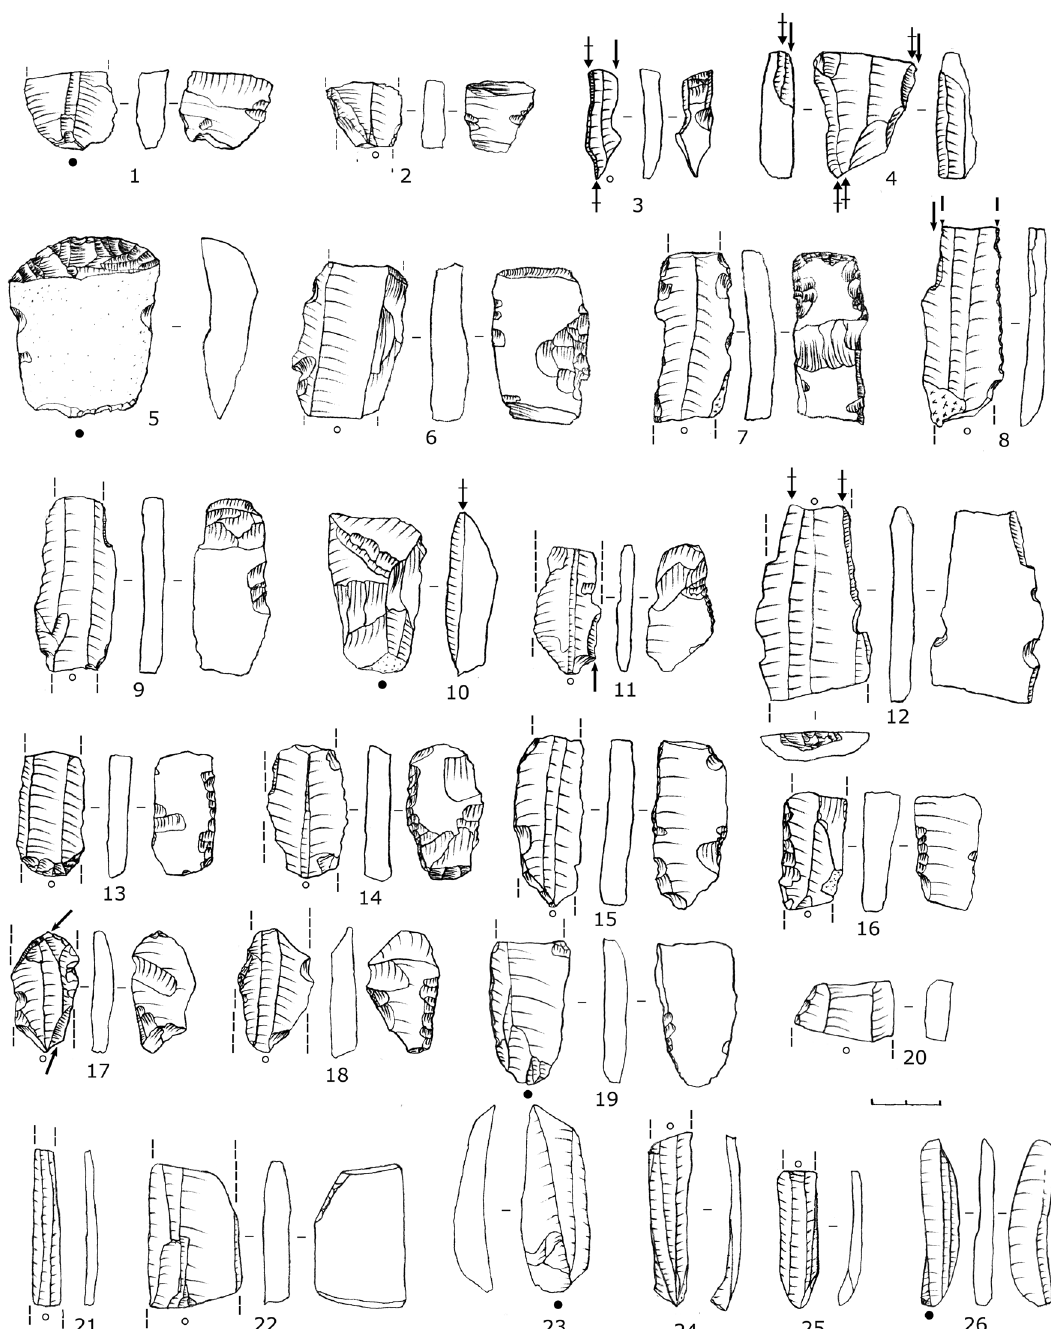
Figure 9: Kamyana Mohyla 1, layer B: lithic inventory. Arrow – a burin blow negative without a counter - bulb; crossed arrow – a burin blow negative with a counter - bulb; circle – a point of impact; fi lled – with preserved bulb; empty – with no bulb. 1 – 2, 6 – 7, 9, 11, 13 – 18 - Kukrek inserts; 3 – 4, 8, 10, 12 – burins; 5 – endscraper, 19 – 20 – retouched blades; 21 – 26 – blades and